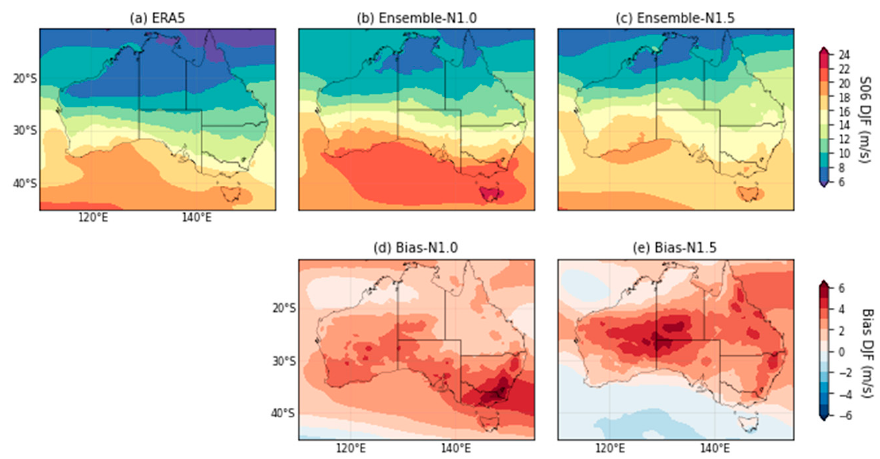
Figure A12. As in Figure A11 except for DJF.